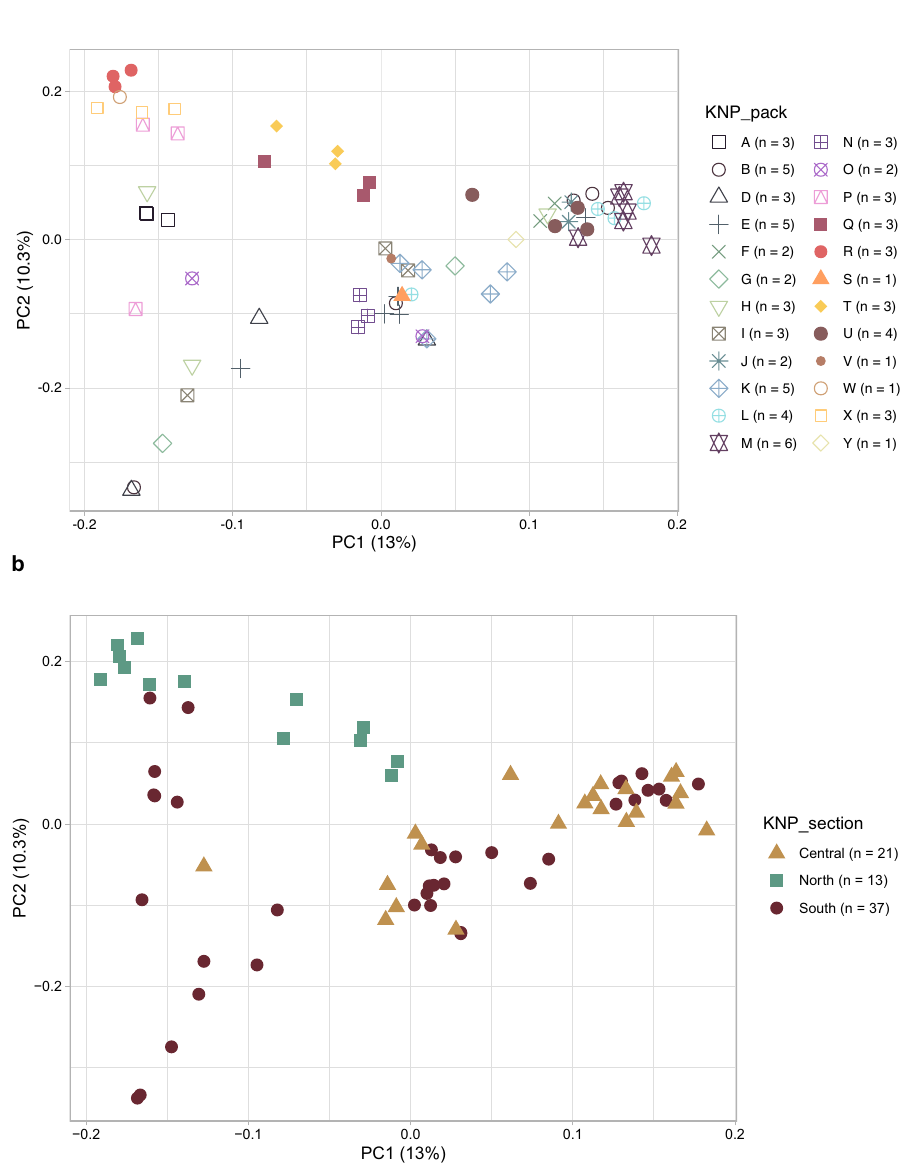
Figure 2. A scatterplot from a principal component analysis (PCA) of 71 African wild dog ( Lycaon pictus ) samples (24 packs) from the Kruger National Park (KNP), South Africa. The first two principal component (PC) axes 1 and 2 are shown, with the percent (%) variance accounted for by each indicated in parentheses. ( a ) Each data point in the scatterplot represents an individual, with the coloured shapes corresponding to the pack (KNP_pack). ( b ) Colours and shapes correspond to an individual’s geographical location in